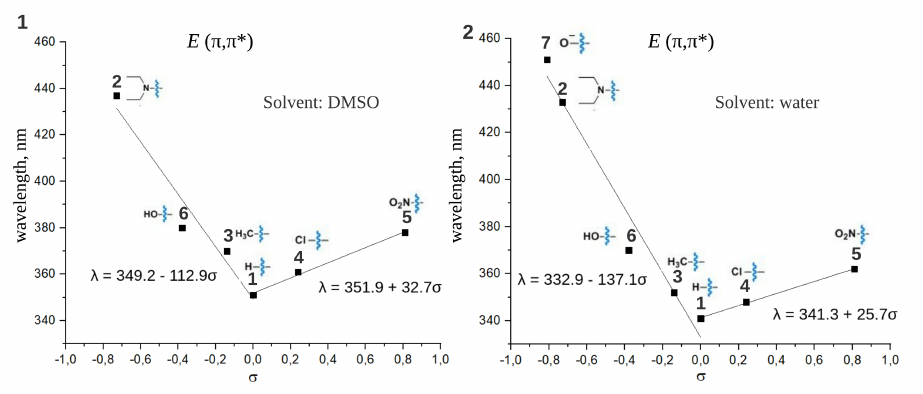
Figure 4. The dependence of absorption band maximum of the E form ( λ E max ) for the ( π , π ∗ ) transi- tions on the Hammett constants of substituents ( σ ). Spectra are recorded in DMSO ( 1 ) and water ( 2 ). The dependencies were approximated by linear functions for σ > 0 and σ < 0 separately, parameters of approximations are given in the